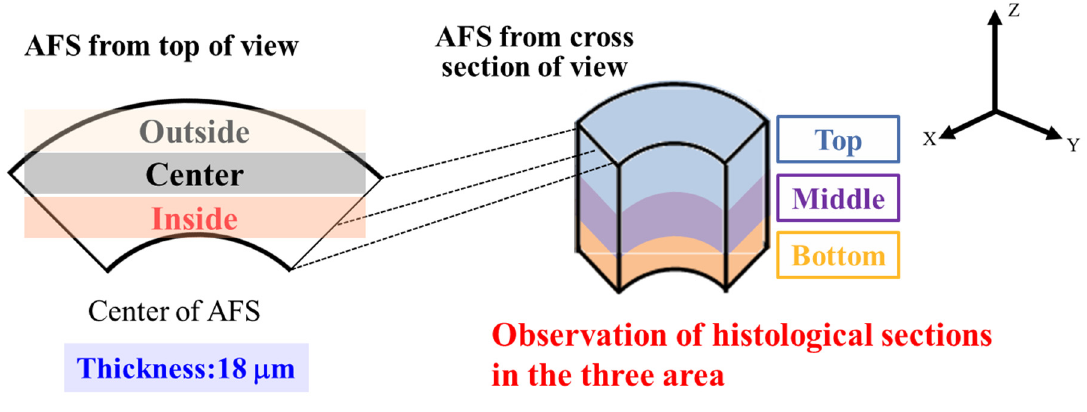
Figure 9. Observation direction of tissue-engineered bone.